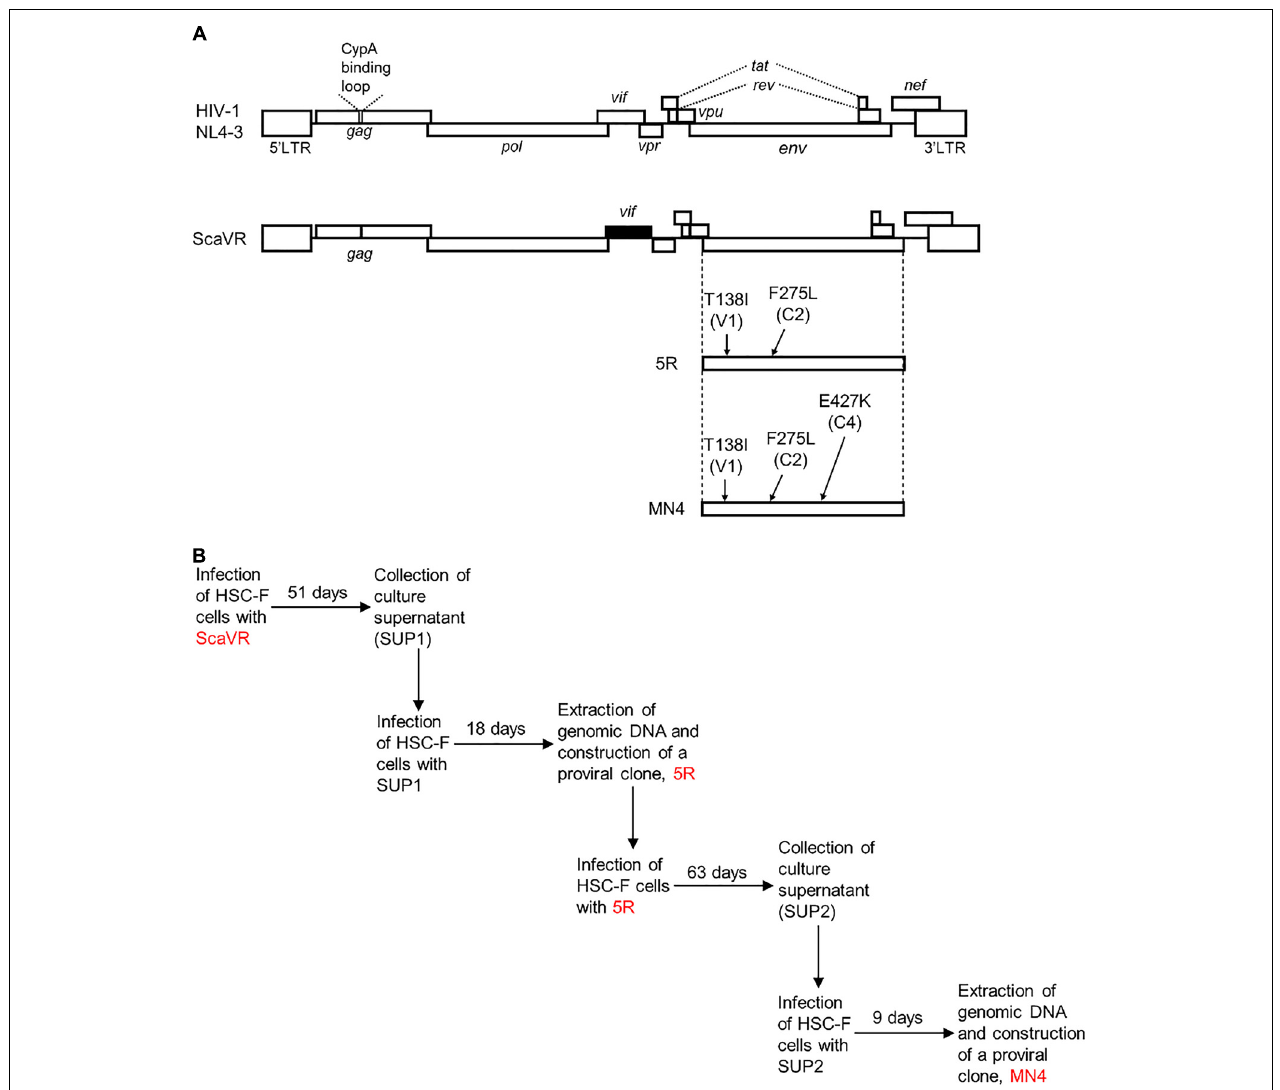
FIGURE 1 | Proviral clones used in this study. (A) Genomes of HIV-1 NL4 − 3 and its derivative HIV-1mt clone (ScaVR). Sequences from HIV-1 NL4 − 3 (GenBank accession number AF324493) and SIVmac MA239 (GenBank accession number M33262) are shown by white and black boxes, respectively. Amino acid mutations and their locations (Env domains in parentheses) in Env-gp120 of 5R and MN4 clones are indicated. CypA, cyclophilin A. (B) In vitro adaptation processes of HIV-1mt clones in HSC-F cells. Details for prolonged cultures of HSC-F cells infected with ScaVR and 5R (Genbank accession number AB266485) have